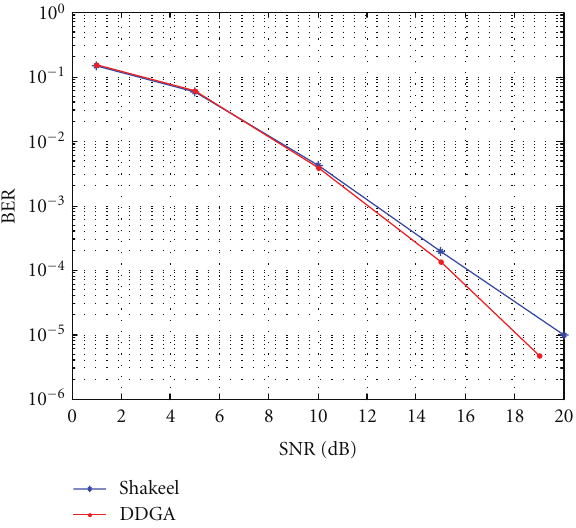
Figure 22: Performances of DDGA, and Shakeel algorithms for BCH (31,16,7) code over RC.